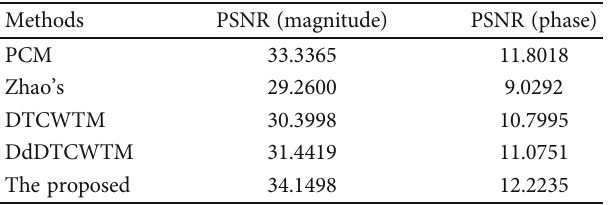
Figure 6: The fi rst row is the true magnitude image of the second dataset and the magnitude results of the proposed method, PCM, Zhao ’ s method, DTCWTM, and DdDTCWTM, respectively. The corresponding magnitude error maps are shown in the middle row. The last line is the true phase image of the second dataset and the phase results of these Table 2: Comparison of PSNRs of the fi ve methods under the same sampling pattern for the second dataset.